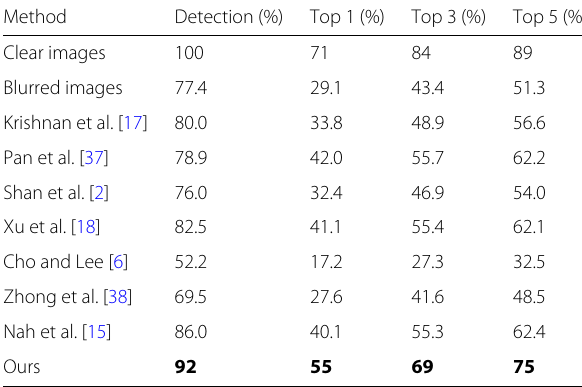
Table 3 Quantitative evaluation for face detection and recognition on the CelebA dataset